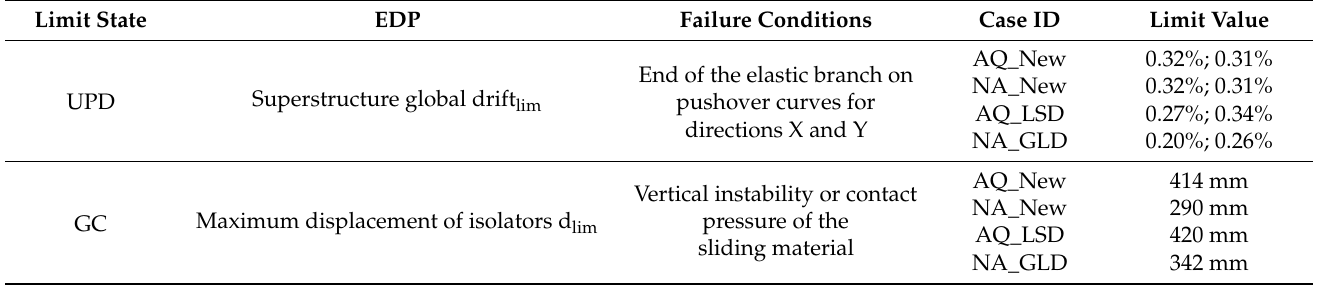
Figure 10. Limit displacement function of the contact pressure of DCCSS sliding material for the GC performance level. Table 5. Definition of the performance levels for the isolated buildings.